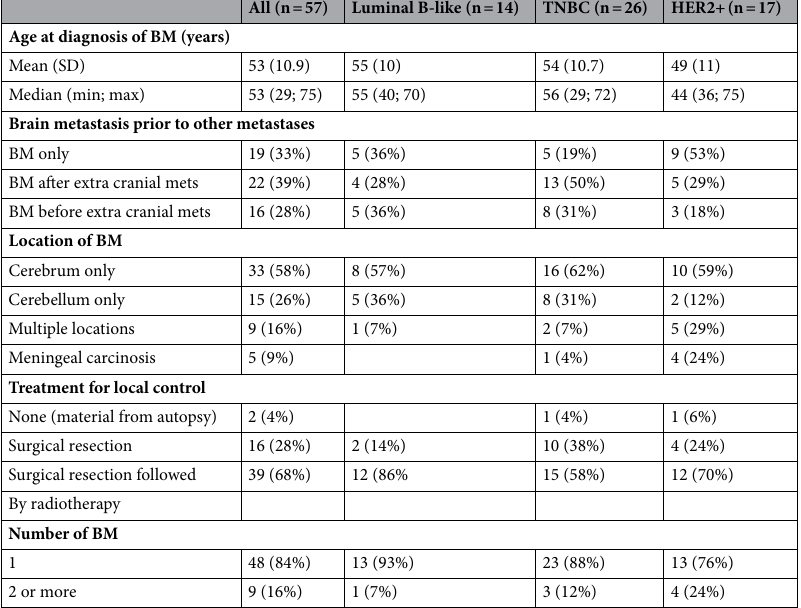
Table 2. Clinical data of the 52 patients with available brain